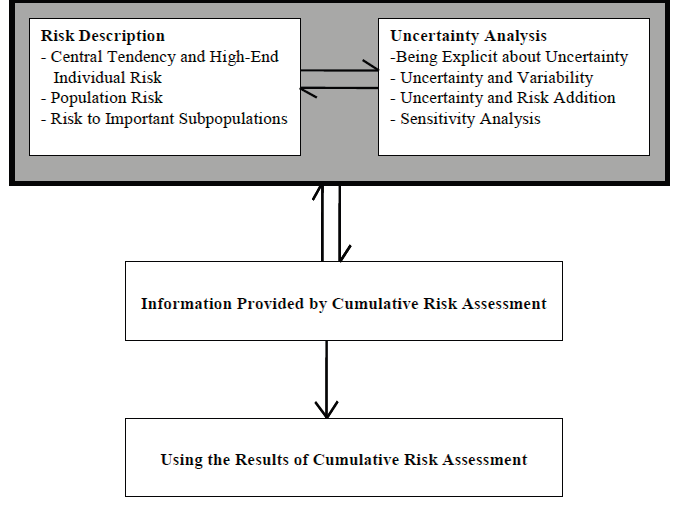
Figure 1. Three phases of a cumulative risk assessment highlighting several features of each; from the EPA Framework for Cumulative Risk Assessment (2003)